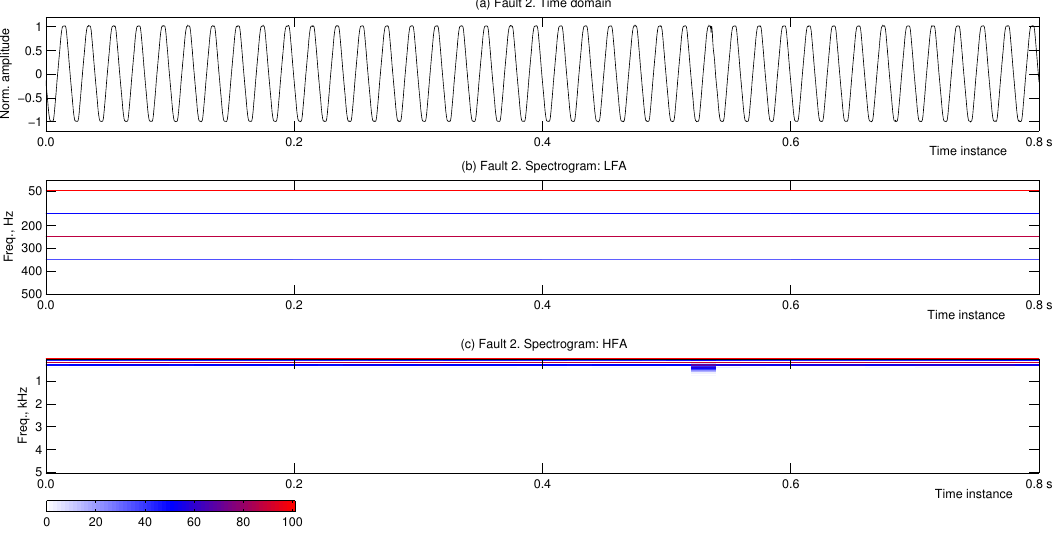
Figure 4. Fault #2: Impulsive transient (Dirac delta). Only the HFA, in the third subfigure, is capable of detecting the Dirac